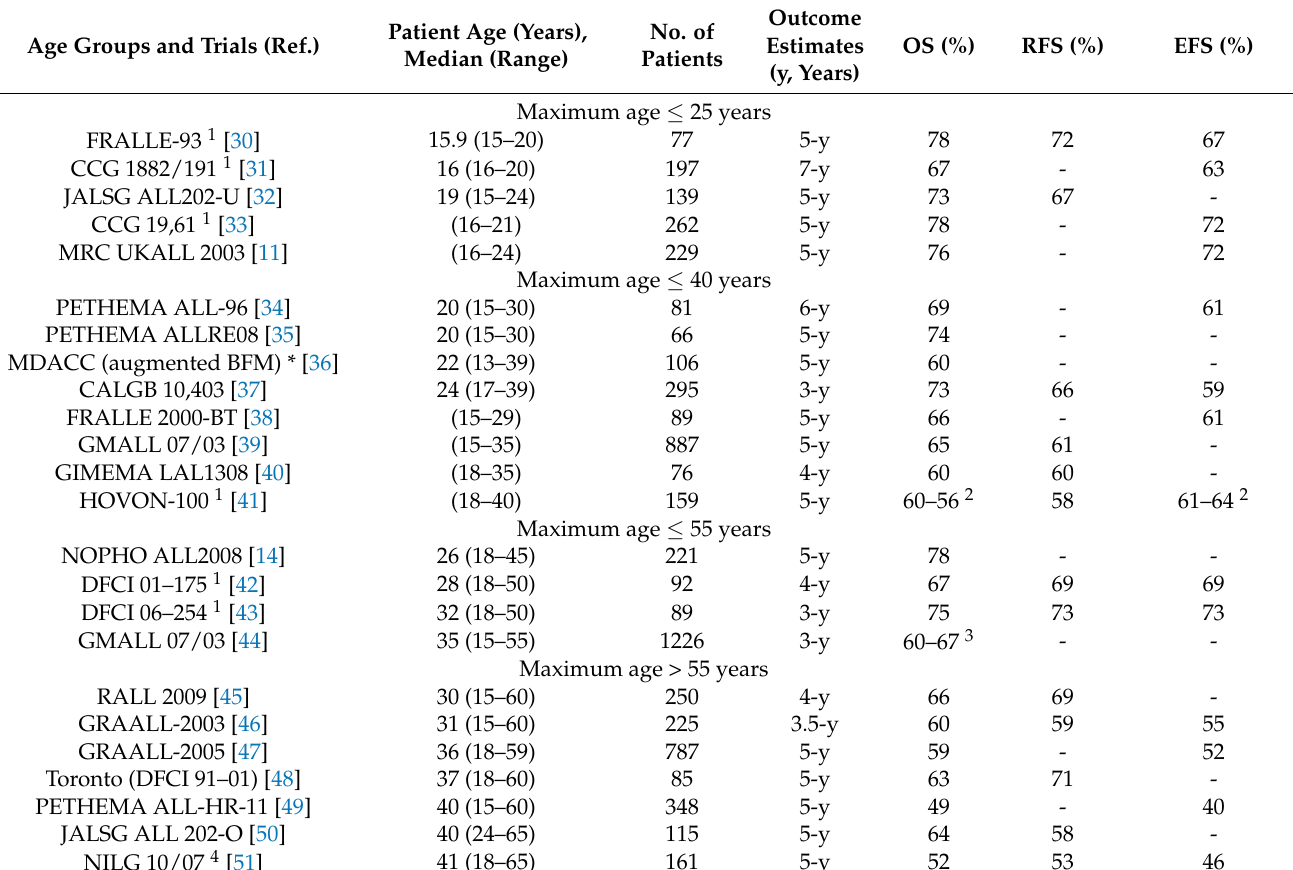
Table 2. Key findings from selected trials of pediatric-based regimens for AYA and adult Ph − ALL. The projected overall survival (OS), relapse-free survival (RFS) and event-free survival(EFS) at ≥ 3 years are shown. Data are ordered according to increasing patient age